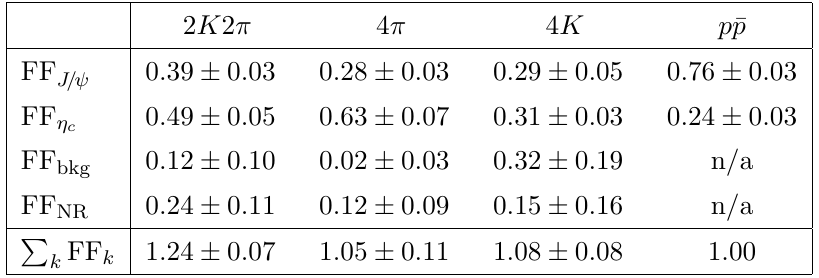
Table 5 . Fit fractions obtained from the parameters of the simultaneous (cid:12)t to the p (cid:22) p and 4 h invariant-mass spectra. Uncertainties are statistical only. Due to interference